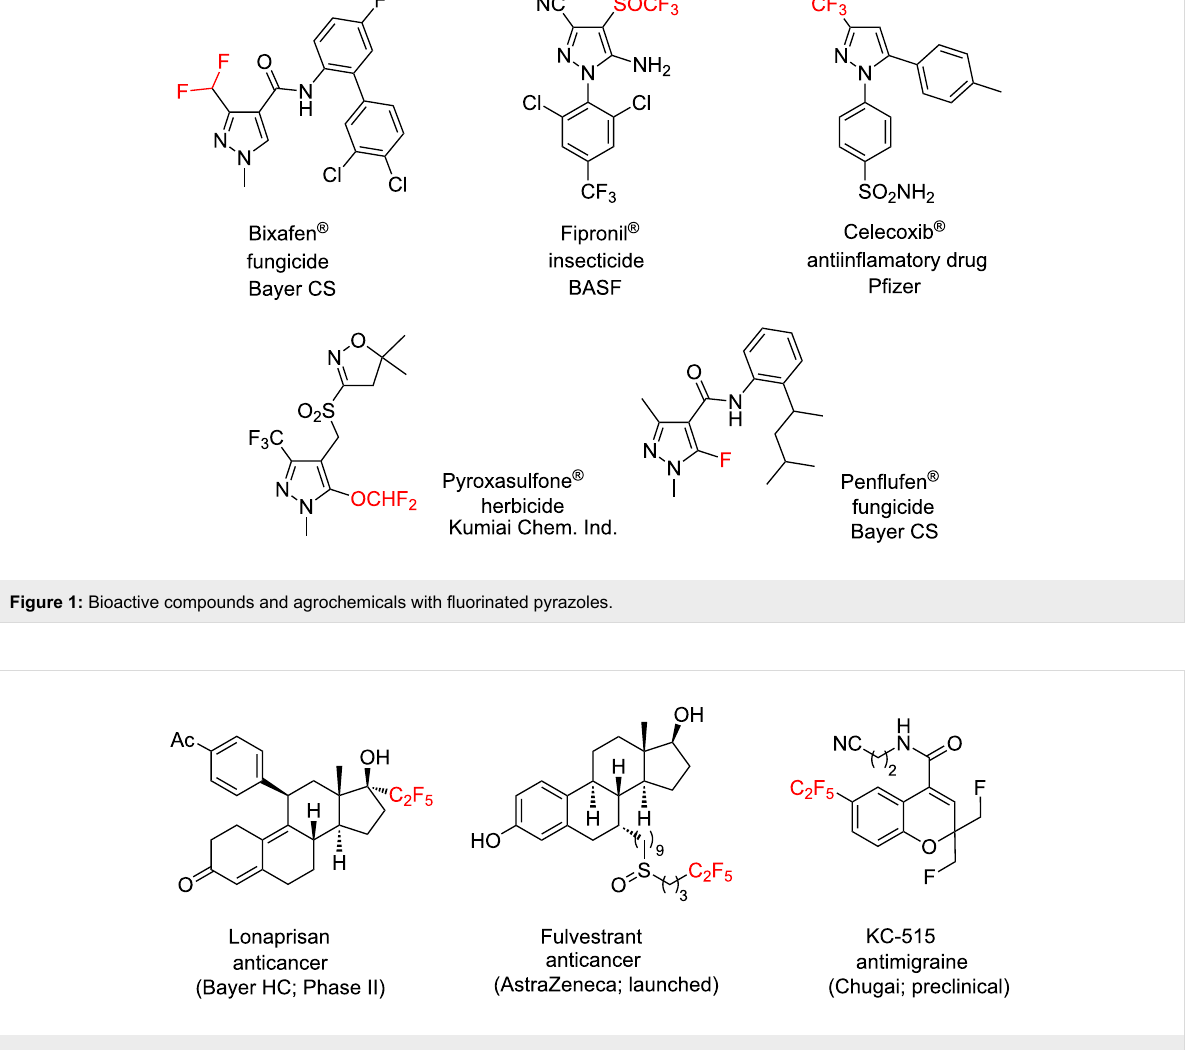
Figure 2: Bioactive compounds with C 2 F 5 group